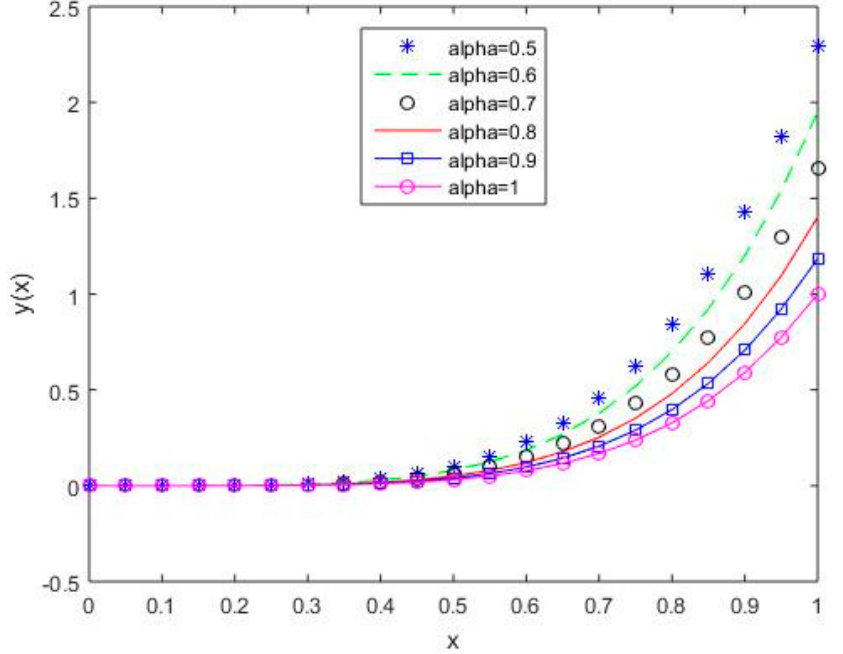
Figure 6. The behavior of solutions using S1 for α values of 0.5, 0.6, 0.7, 0.8, 0.9, and 1, Example 1.